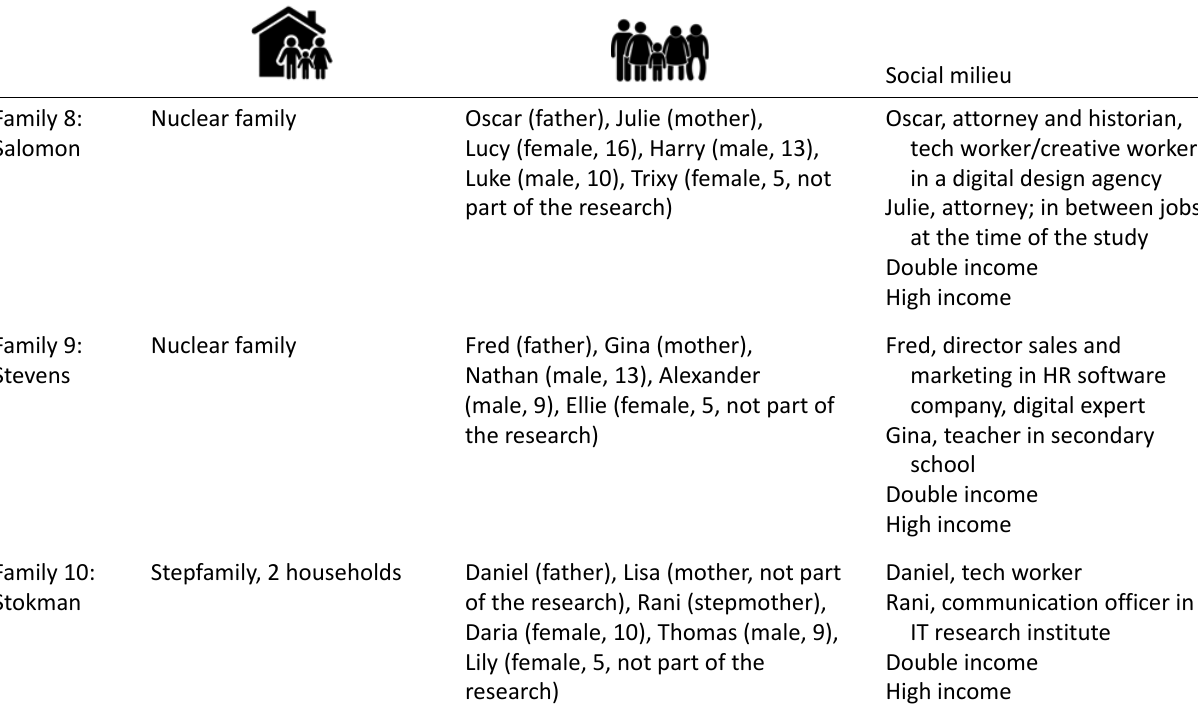
Table 1. (Cont.) Overview of families.